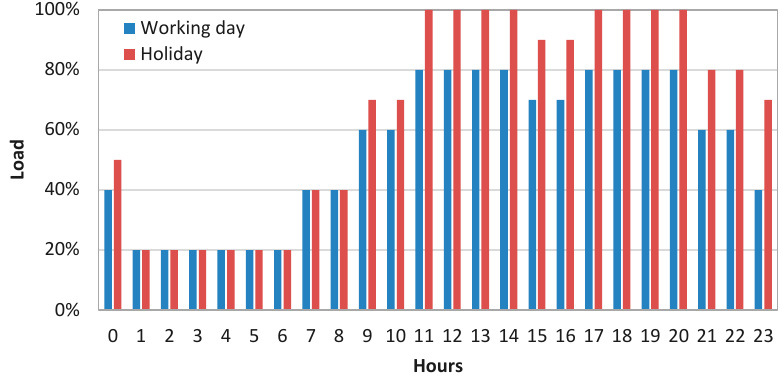
Figure 4. Hourly load profiles of electric demand (excluding cooling production) of the commercial center on working days and holidays.